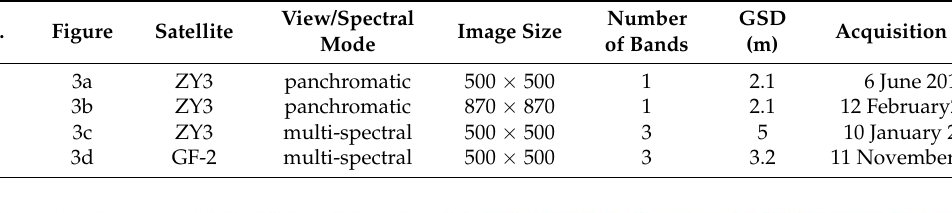
Table 1. Parameters of simulation experimental imagery.